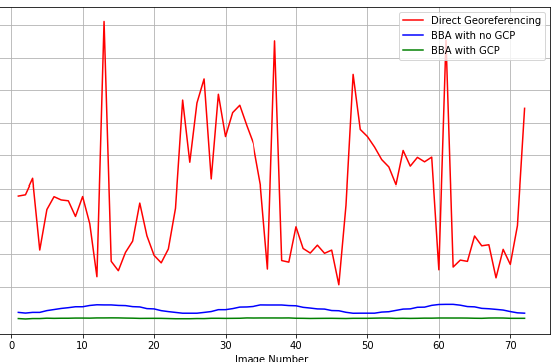
Figure 5. Analysis of Mean Absolute Errors (MAE) for positional accuracy using direct georeferencing before the proposed correction, BBA with GCPs and BBA with no GCPs